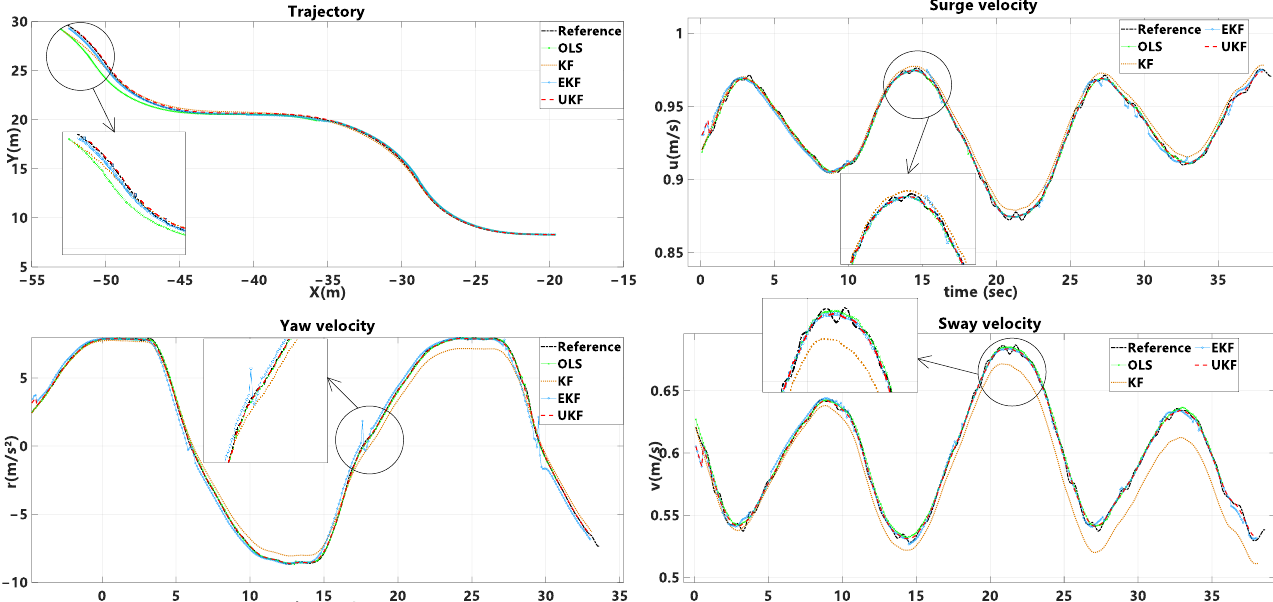
Figure 10. Comparison diagram of ship identification results using different algorithms.